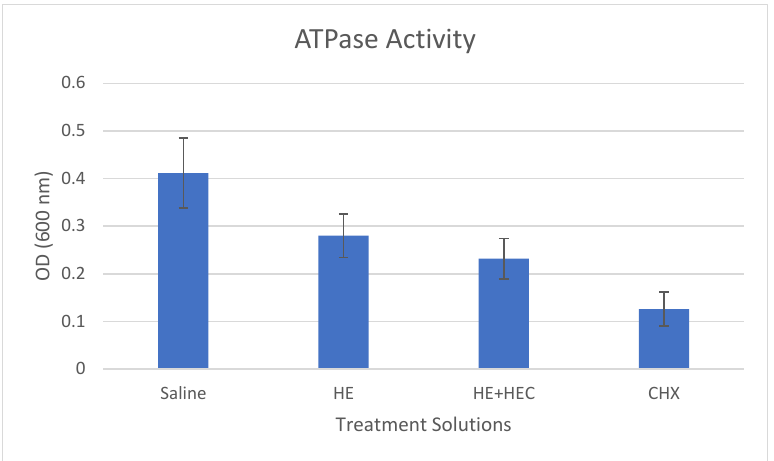
Figure 2. Effect of the various treatment solutions on Streptococcus mutans lactic acid production: saline as negative control; herbal extracts (HE); combined herbal extracts and hydroxyethyl cellulose (HE + HEC); and chlorhexidine (CHX) as positive control. Results (± standard deviation) measured using a colorimetric assay are presented as OD (600 nm) units.